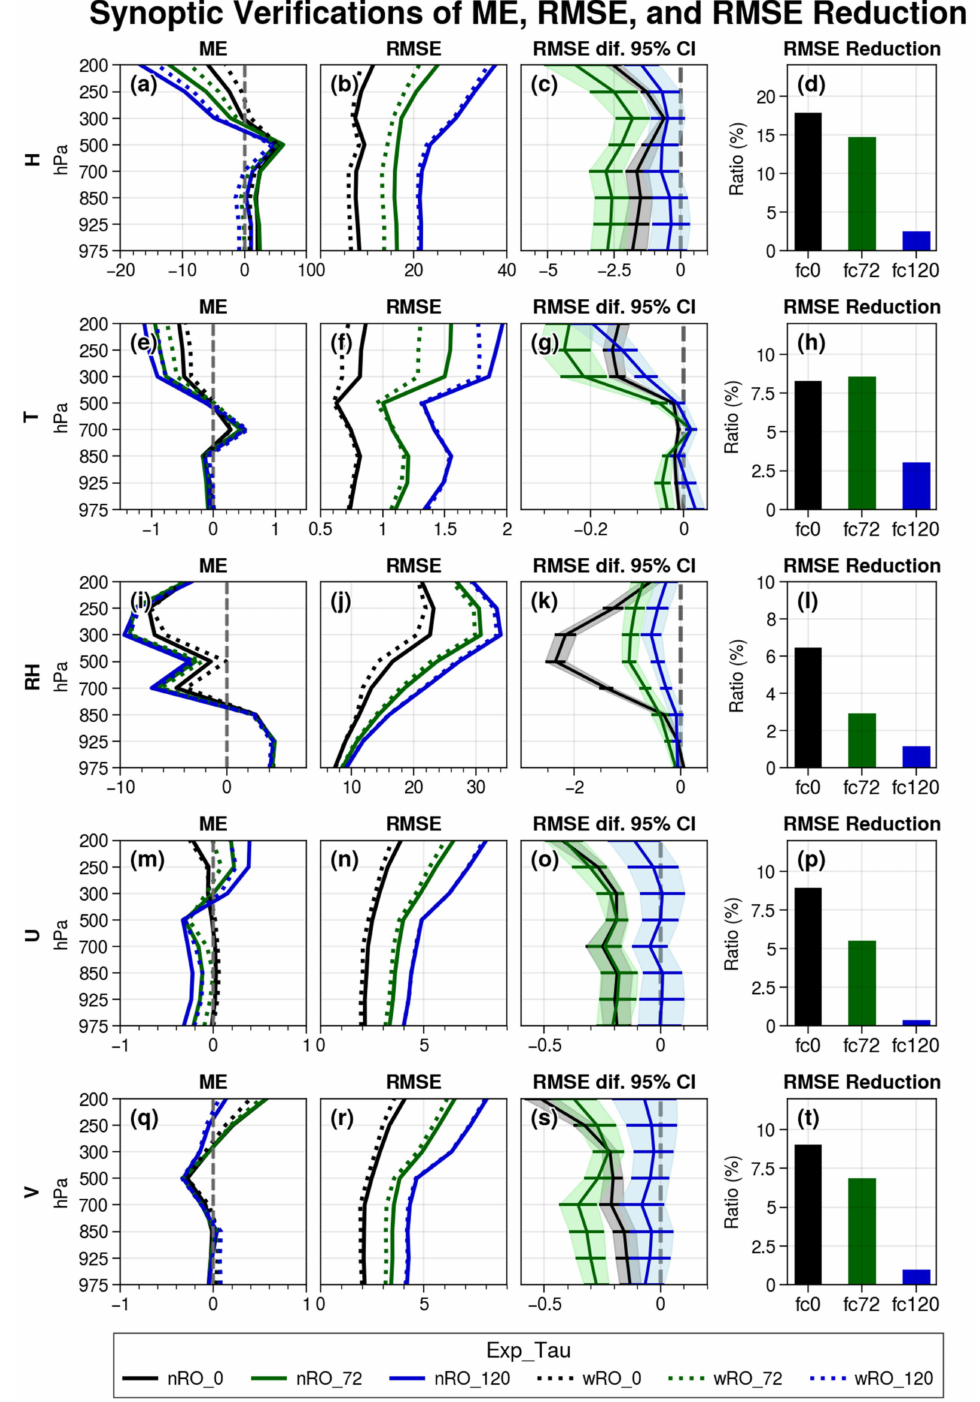
Figure 6. Grid verifications of nRO and wRO forecasts against the 0.25 ◦ × 0.25 ◦ NCEP GFS analysis. Averaging with a total of 93 cases (the same period as in Figure 2), ( a,e,i,m,q ) the vertical profiles of ME (the first column), ( b,f,j,n,r ) RMSE (the second column), ( c,g,k,o,s ) RMSE differences with 95% confident interval (CI) (the third column), and ( d,h,l,p,t ) RMSE reduction ratio (the fourth column) are computed at 0 (black), 72 (green), and 120 (blue) forecast hours, and presents in geopotential height (H, unit: meter), temperature (T, unit: K), relative humidity (RH, unit: %), and u and v wind speed (U and V, unit: m/s), respectively. The RMSE reductions were computed by the RMSEs of (nRO − wRO)/nRO ×